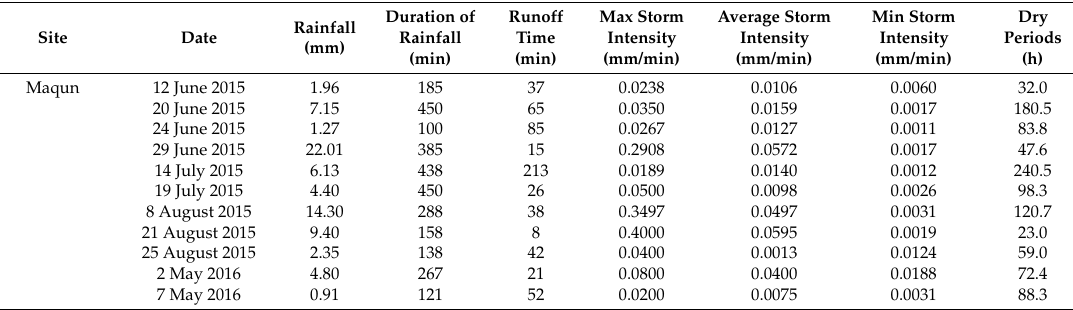
Table 2. Rainfall characteristics in study